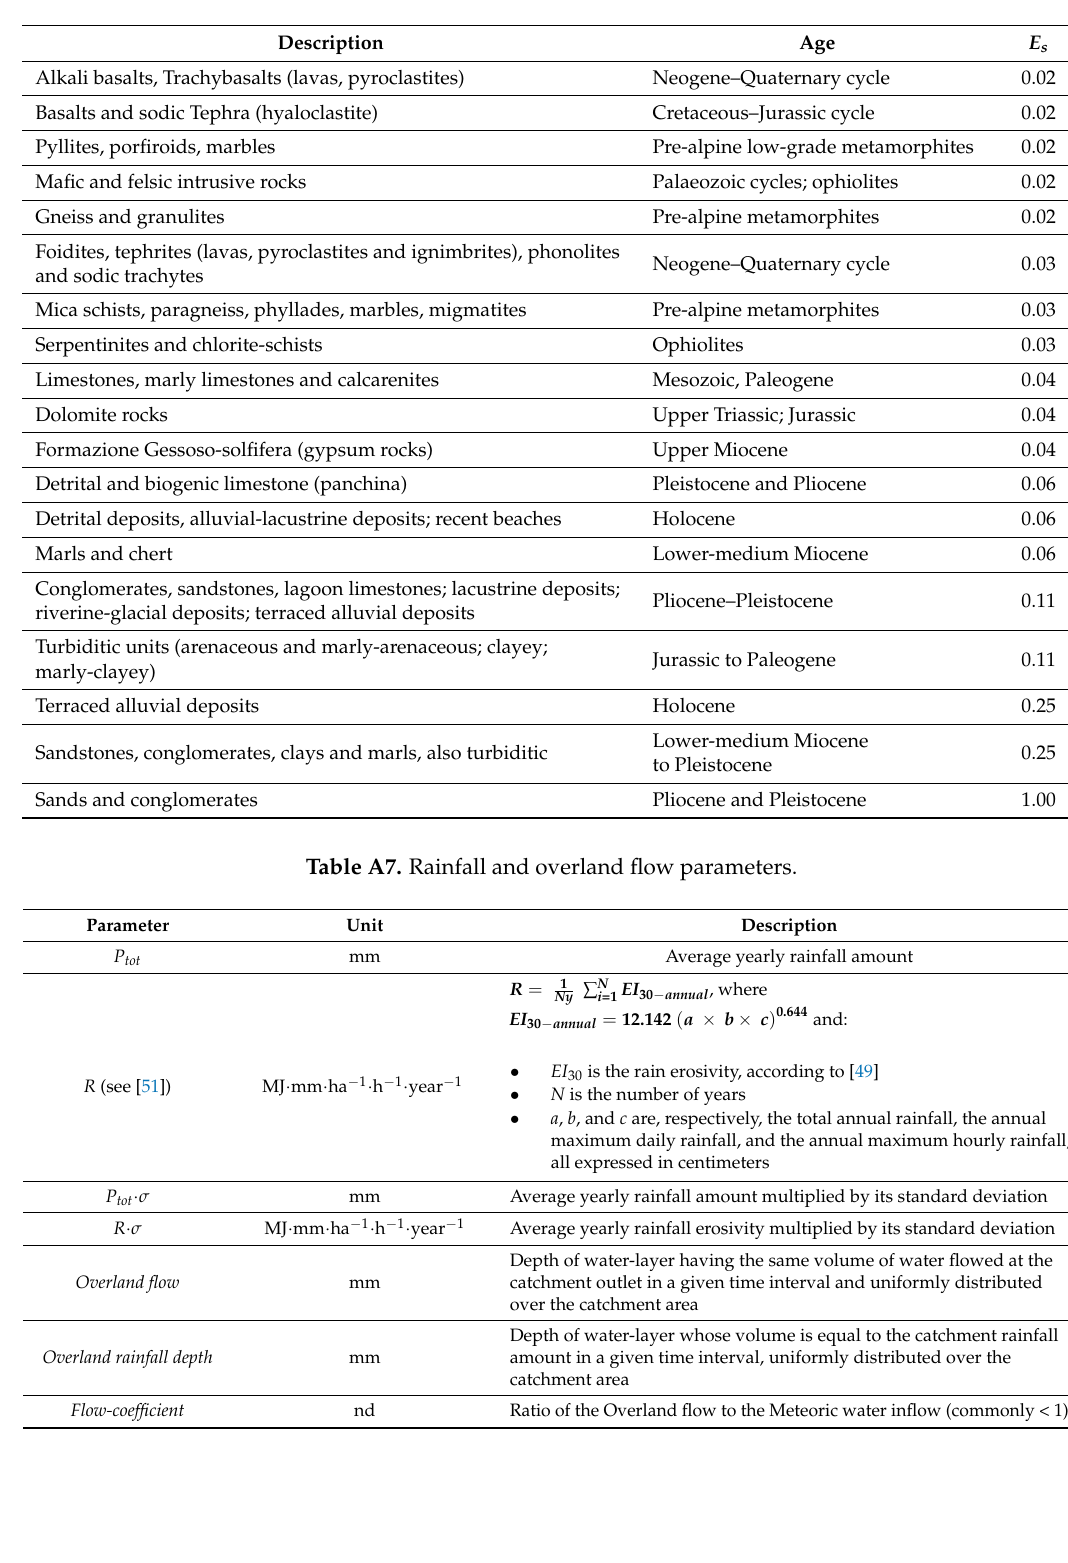
Table A6. Erodibility scores assigned to main units reported in the Geolithological Map of Italy [38].